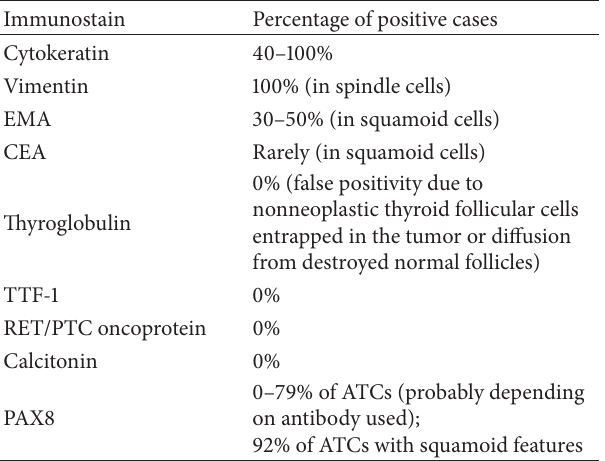
Table 3: Immunohistochemical features of